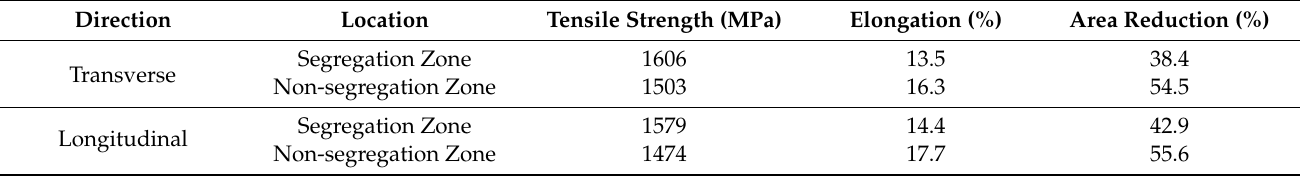
Figure 3. Stress–strain curves of the segregation zone (SZ) and the non-segregation zone (NSZ) in different directions. Table 1. Tensile properties of the NM450 steel specimens in different